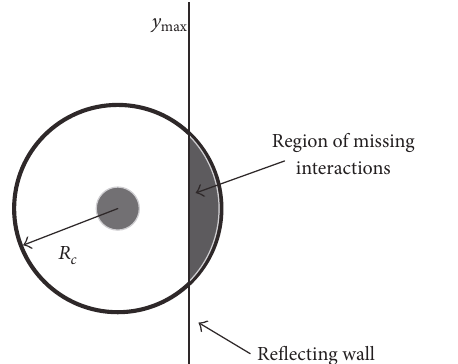
Figure 4: Missing interaction region due to the nonperiodic boun- dary at the MD-continuum interface 𝑦